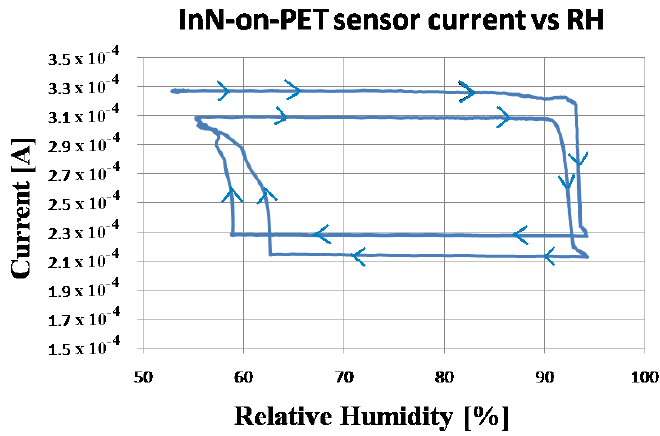
Figure 6. Sensor signal (current) versus relative humidity for the InN-on-PET sensor. The arrows indicate the succession in time measured during the